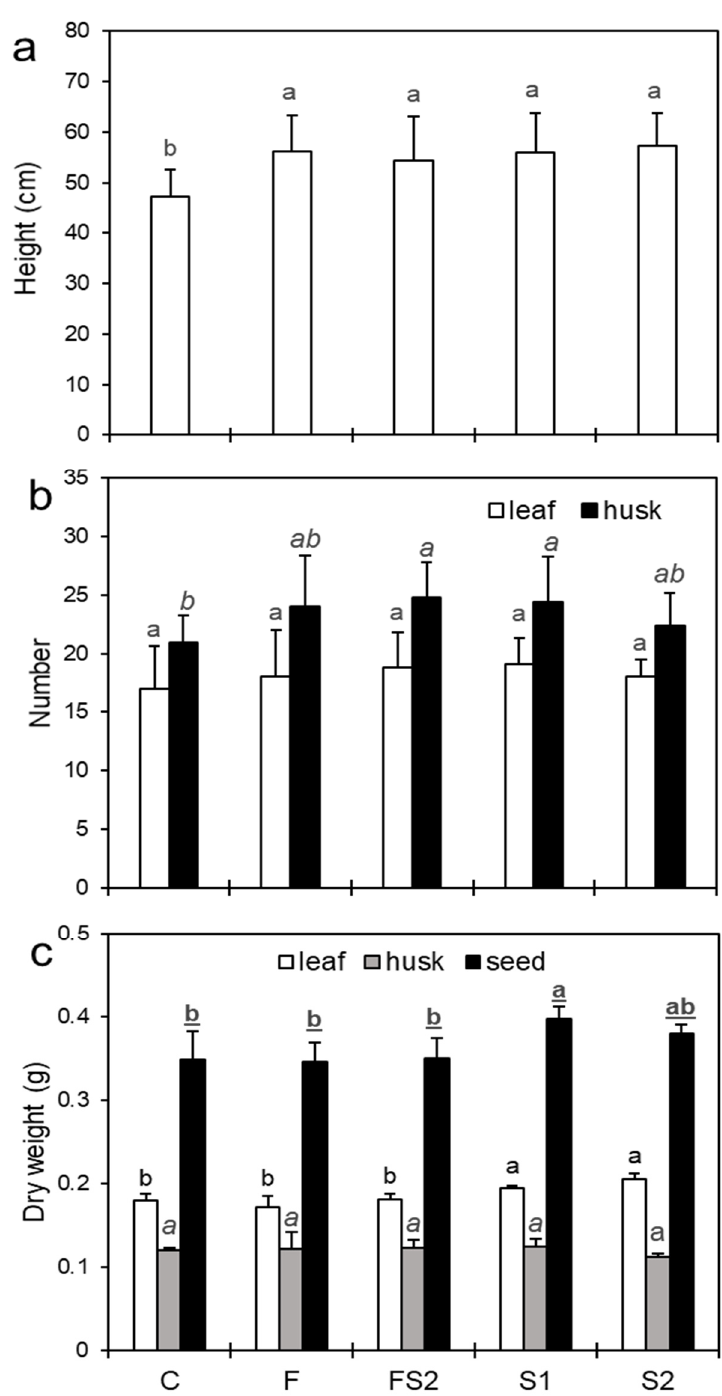
Figure 1. Effect of EAF slag on plant growth. ( a ) Plant height, ( b ) number of leaves and husks, and ( c ) dry weight of leaf, husk and seed in bean plants cultivated in: control soil (C—soil without EAF slag or NPK fertilizer), soil enriched with NPK fertilizer (F), soil enriched with a combination of 2% EAF slag and NPK fertilizer (FS2), and soil enriched with EAF slag (S1—at 1%, S2—at 2% level). Error bars present standard deviations. Different letters indicate significantly different values at p <